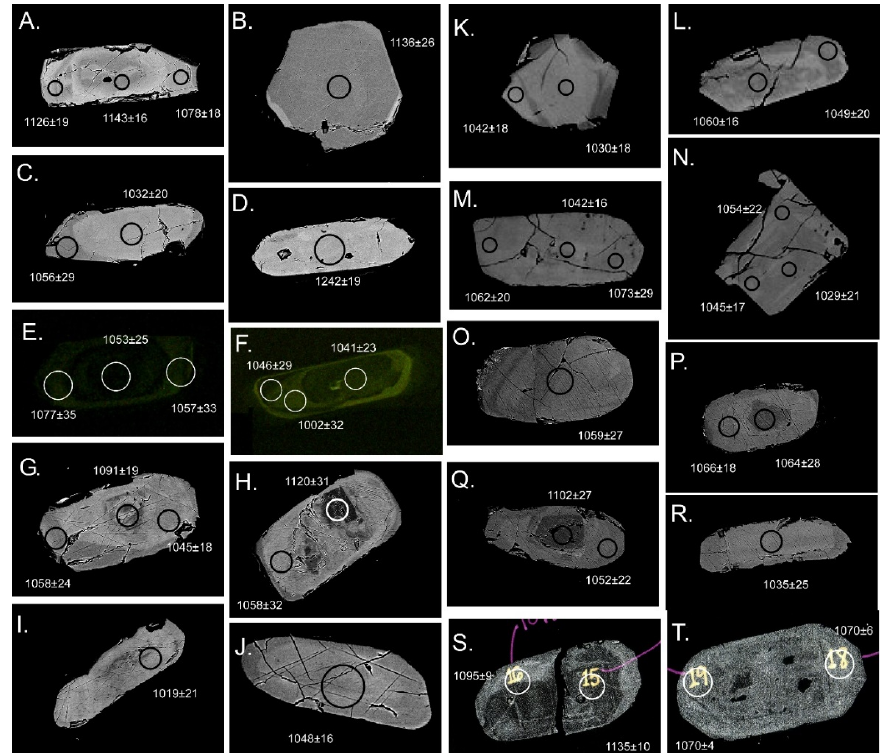
Figure 6. Backscatter electron (BSE) or cathodoluminescence (CL) mode scanning electron photomicrographs of representative zircon grains and analyses from each sample. The circles in each photograph are 30 µm and represent laser ablation analysis locations. 207 Pb/ 206 Pb ages given. ( A ) CVE-1 BSE. Subhedral, elongate grain with irregularly zoned core (1143 ± 16 Ma), oscillatory zoning (1126 ± 19 Ma), homogeneous rim (1078 ± 18 Ma), and euhedral inclusion (dark). ( B ) CVE-1 BSE. Subhedral, equant grain with homogenous core (1145 ± 17 Ma) and thin (<10 µm) rim (undated). ( C ) CVE-1 BSE. Dipyramidal grain with bright core (1032 ± 20 Ma) and darker edge of grain (1056 ± 20 Ma). ( D ) CVE-1 BSE. Euhedral elongate dipyramidal grain with a homogenous interior (1242 ± 19 Ma), which was interpreted as a xenocryst. ( E ) CVE-2 CL. Euhedral, elongate dipyramidal crystal with dark, zoned center (1053 ± 25 Ma) and lighter concentric rim (1057 ± 33 and 1077 ± 35 Ma). ( F ) CVE-2 CL. Euhedral, elongate dipyramidal crystal with dark, unzoned center (1041 ± 23 Ma) and lighter zoned concentric rims (1046 ± 23 and 1046 ± 29 Ma). ( G ) CVE-3 BSE. Subhedral, elongate, dipyramidal crystal with mottled core (1091 ± 19 Ma), light inner rim (1045 ± 18 Ma), and dark outer rim (1058 ± 24 Ma). ( H ) CVE-3 BSE. Rectangular grain with a complex, mottled core (1120 ± 31 Ma) and lighter rim (1058 ± 24 Ma). ( I ) CVE-3 BSE. Subhedral, elongate dipyramidal grain with a mottled core (undated) and brighter, homogenous rim (1019 ± 21 Ma). ( J ) CVE-3 BSE. Subhedral, elongate dipyramidal, homogeneous grain with vague internal zonation (1048 ± 16 Ma). ( K ) CVE-4 BSE. Equant, anhedral crystal with homogenous center (1030 ± 18 Ma) and edge (1042 ± 18 Ma). ( L ) CVE-4 BSE. Elongate, dipyramidalgrainwithamottledcenter(1049 ± 20Ma)andahomogeneousedge(1060 ± 16Ma). ( M )CVE-4 BSE. Elongate, dipyramidal, homogeneous grain with tiny, black quartz inclusions (center—1042 ± 16 Ma, edge—1060 ± 20 Ma). ( N ) CVE-4 BSE. Rectangular, concentrically zoned, grain (center—1029 ± 21 Ma, edges—1045 ± 17 and 1054 ± 22 Ma). ( O ) CV-7 BSE. Slightly rounded, elongate, subhedral grain with zoning (1059 ± 27 Ma). ( P ) CV-7 BSE. Slightly rounded, elongate, subhedral grain with dark, homogenous interior (1064 ± 28 Ma) and brighter, homogeneous outer zone (1066 ± 18 Ma). ( Q ) CV-7 BSE. Slightly rounded, elongate, subhedral grain with a dark core (1102 ± 27 Ma) and zoned rim (1052 ± 22 Ma). ( R ) CV-7 BSE. Slightly rounded, elongate, subhedral grain with a homogeneous core (1035 ± 25 Ma). ( S ) CV-2013. Slightly elongate, dipyramidal grain with dark resorbed and zoned core (1135 ± 10 Ma) and bright, discontinuous rim (1095 ± 9 Ma). ( T ) CV-2013. Slightly elongate, dipyramidal grain with a mottled, inclusion-filled core (undated) and oscillatory zoned rim (1070 ± 4 and 1070 ± 6